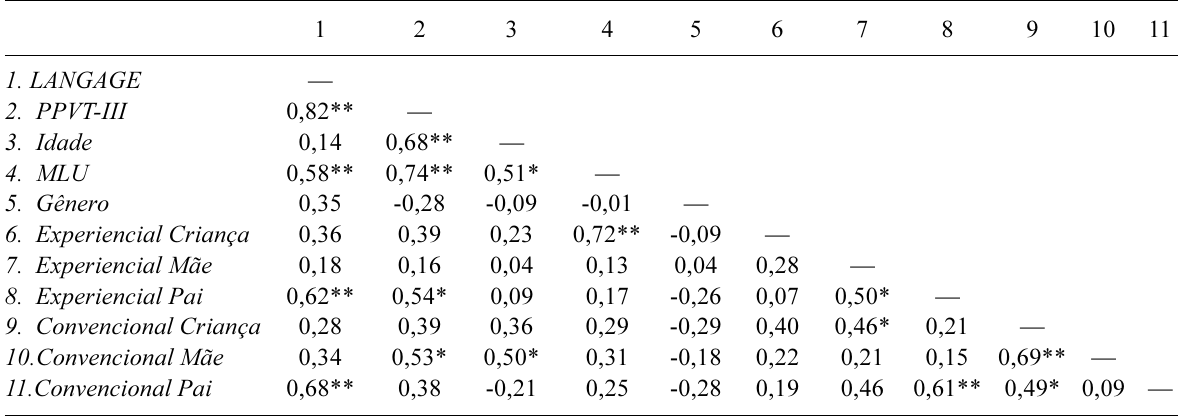
Intercorrelações entre LANGAGE, Idade, MLU, PPVT-III, Uso de Tempo Convencional e de Tempo Experiencial para cada